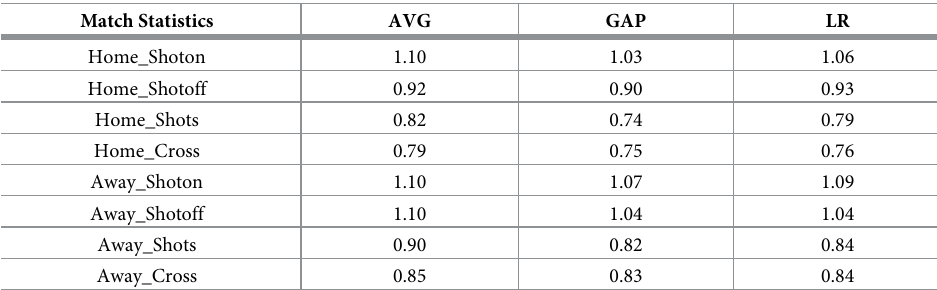
Table 4. Non-rare match statistics prediction